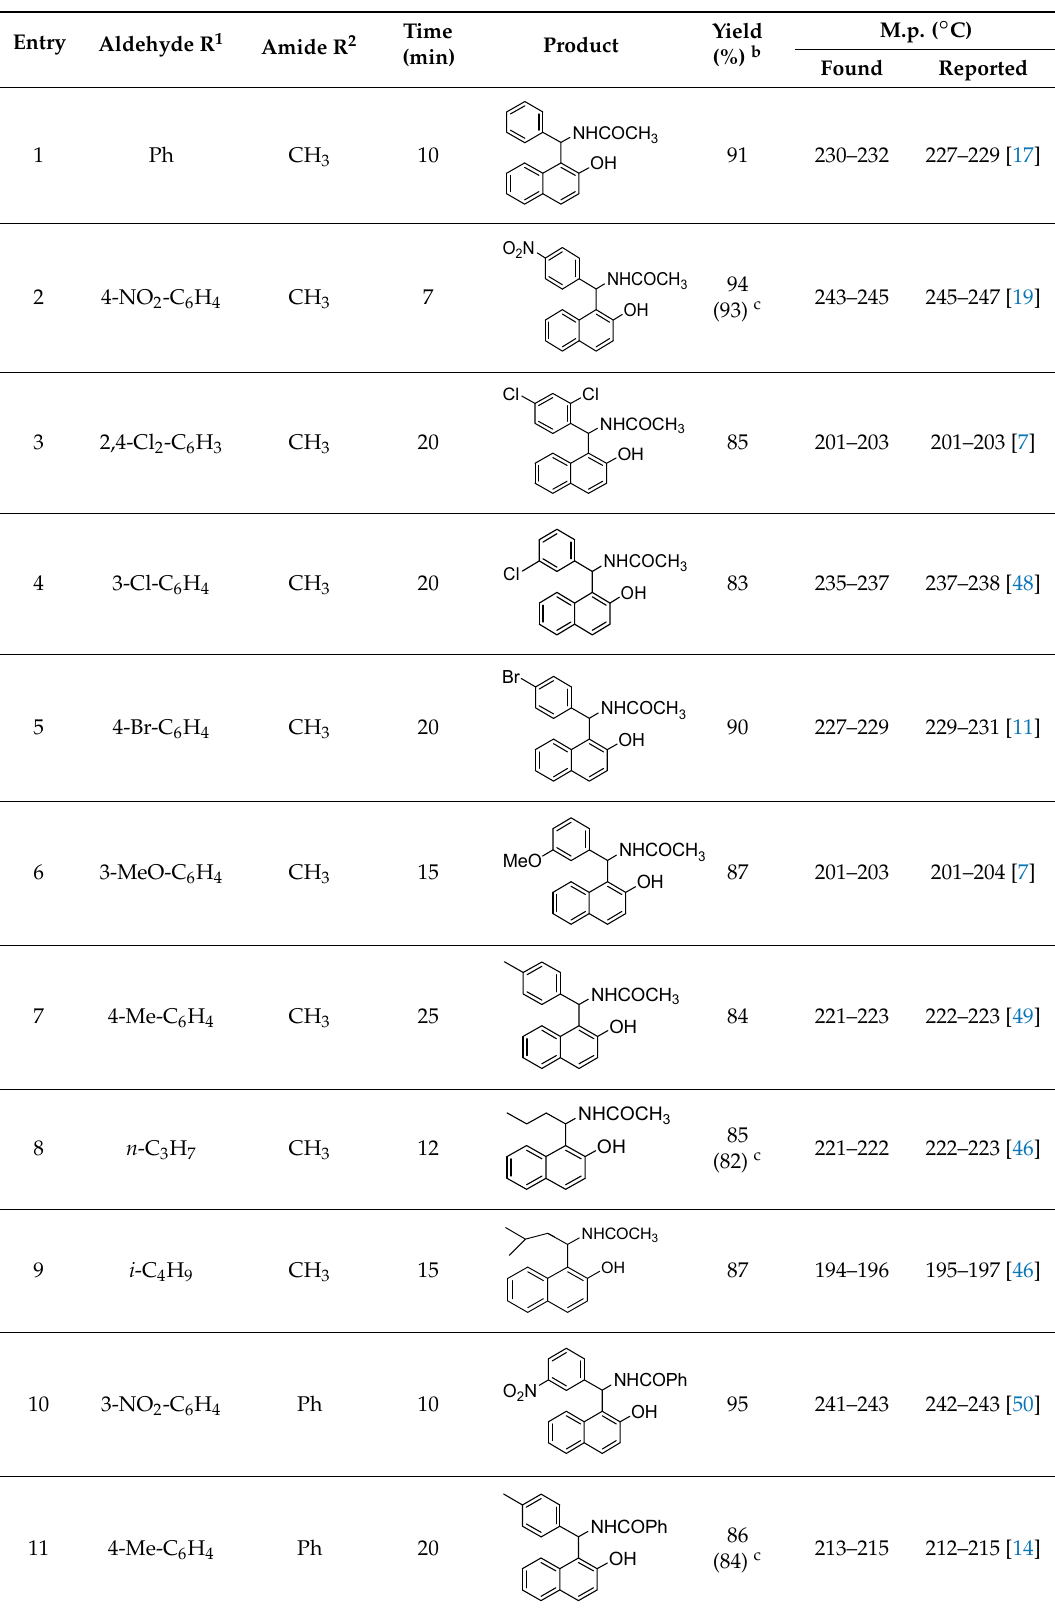
Table 2. One-pot synthesis of 1-amidoalkyl-2-naphthols with different aldehydes and amides catalyzed Table 2. One ‐ pot synthesis of 1 ‐ amidoalkyl ‐ 2 ‐ naphthols with different aldehydes and amides Table 2. One ‐ pot synthesis of 1 ‐ amidoalkyl ‐ 2 ‐ naphthols with different aldehydes and amides Table 2. One ‐ pot synthesis of 1 ‐ amidoalkyl ‐ 2 ‐ naphthols with different aldehydes and amides Table 2. One ‐ pot synthesis of 1 ‐ amidoalkyl ‐ 2 ‐ naphthols with different aldehydes and amides Table 2. One ‐ pot synthesis of 1 ‐ amidoalkyl ‐ 2 ‐ naphthols with different aldehydes and amides Table 2. One ‐ pot synthesis of 1 ‐ amidoalkyl ‐ 2 ‐ naphthols with different aldehydes and amides Table 2. One ‐ pot synthesis of 1 ‐ amidoalkyl ‐ 2 ‐ naphthols with different aldehydes and amides by AIL@MNP a . Table 2. One ‐ pot synthesis of 1 ‐ amidoalkyl ‐ 2 ‐ naphthols with different aldehydes and amides Table 2. One ‐ pot synthesis of 1 ‐ amidoalkyl ‐ 2 ‐ naphthols with different aldehydes and amides Table 2. One ‐ pot synthesis of 1 ‐ amidoalkyl ‐ 2 ‐ naphthols with different aldehydes and amides Table 2. One ‐ pot synthesis of 1 ‐ amidoalkyl ‐ 2 ‐ naphthols with different aldehydes and amides catalyzed by AIL@MNP a . catalyzed by AIL@MNP a catalyzed by AIL@MNP a . catalyzed by AIL@MNP a . catalyzed by AIL@MNP a . catalyzed by AIL@MNP a . catalyzed by AIL@MNP a . catalyzed by AIL@MNP a . catalyzed by AIL@MNP a . catalyzed by AIL@MNP a . catalyzed by AIL@MNP a .